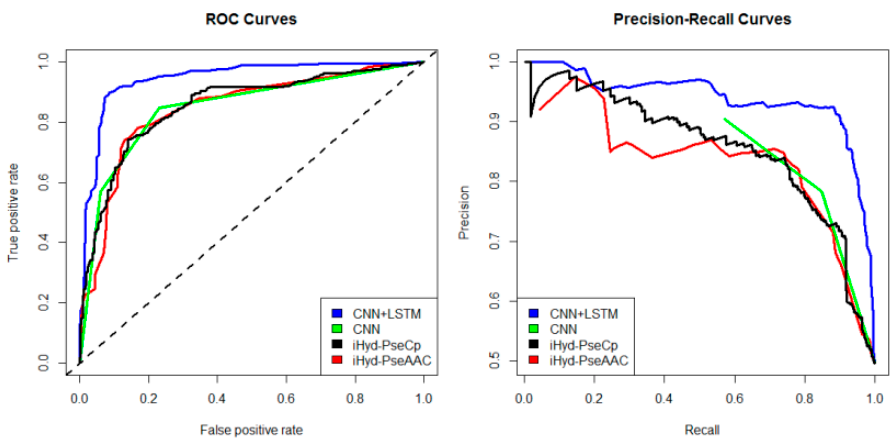
Figure 4. The ROC and Precision-Recall curves to show the performance of CNN+LSTM, CNN, iHyd-PseCp and iHyd-PseAAC for the peptide samples with the center residue being proline on Dataset 3.